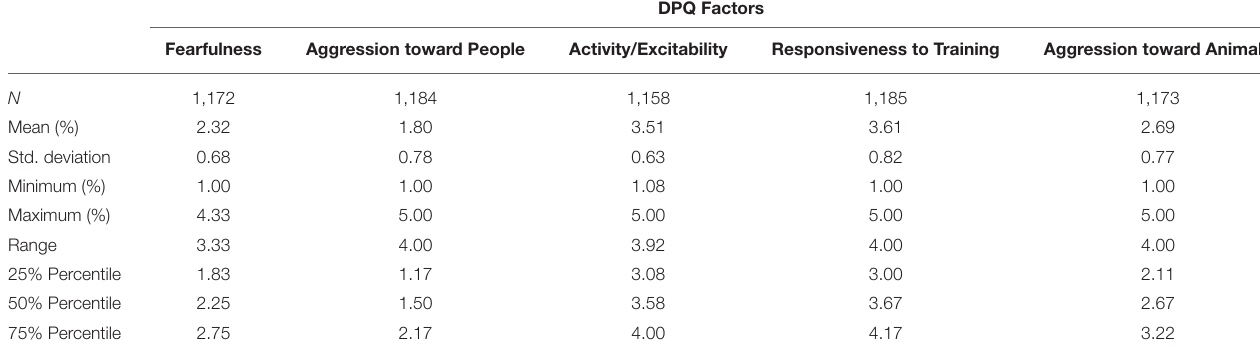
TABLE 2 | Number of subjects, mean, standard deviation, minimum, maximum, range, and quartiles of the Dog Personality Questionnaire factor scores.